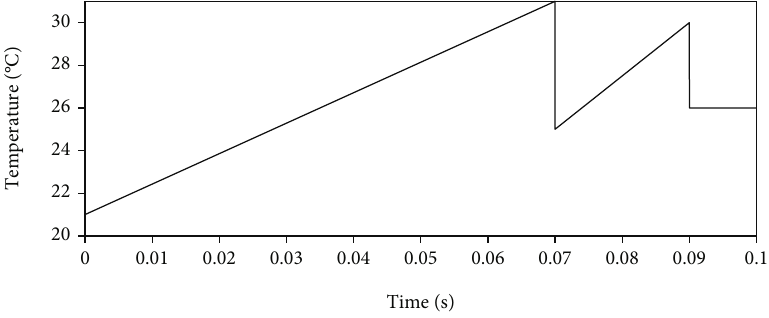
Figure 18: Temperature conditions for Test